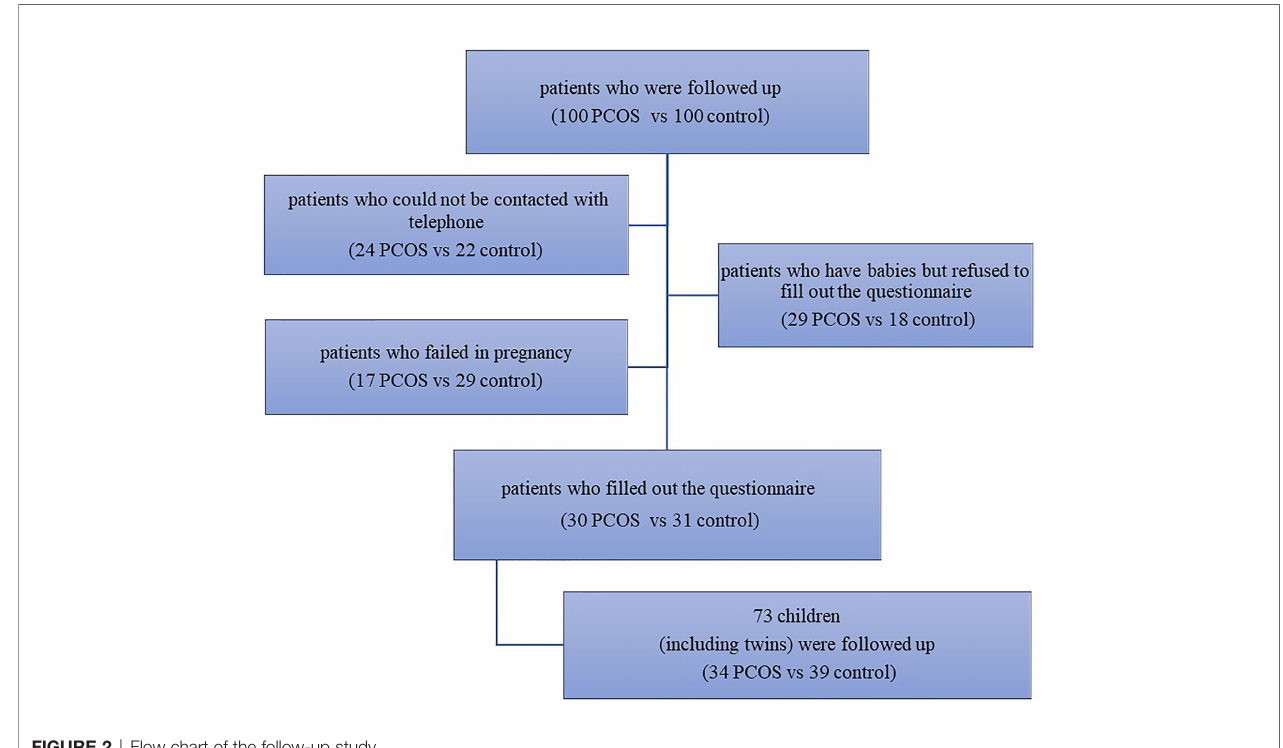
FIGURE 2 | Flow chart of the follow-up